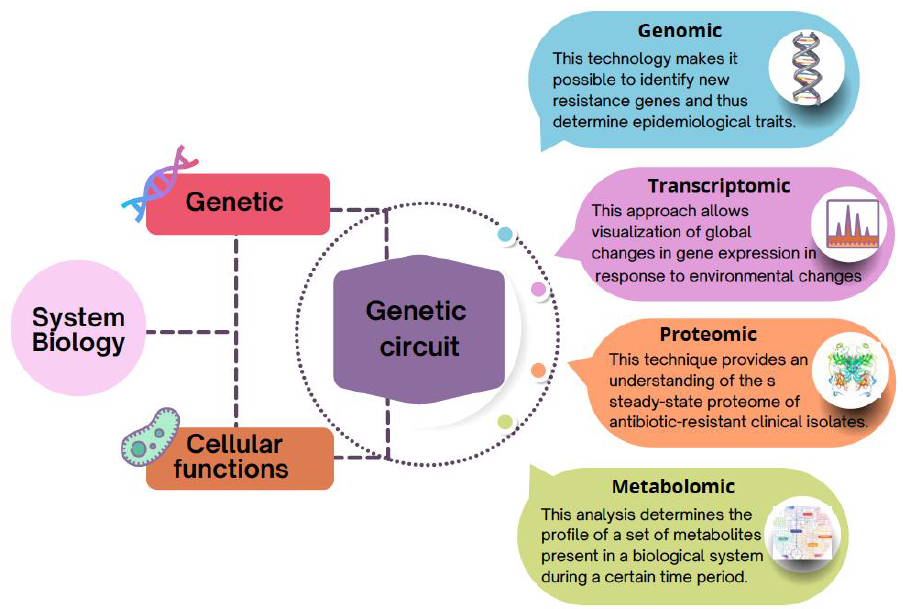
Figure 3. Schematic representation of the genetic circuitry that interconnects the relationship between genetics and cellular functions in a multilayered hierarchy.